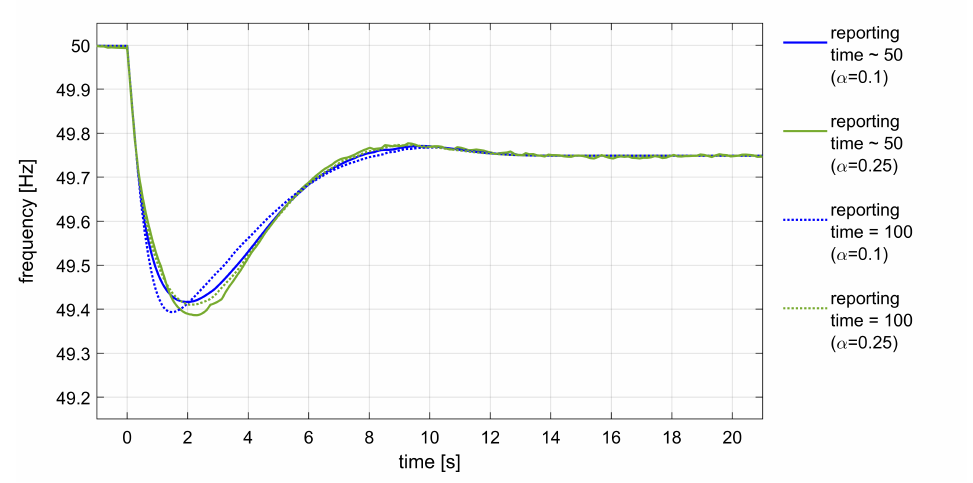
Figure 16. Real controller: frequency response with different reporting time and smoothing factor ( K = 10).